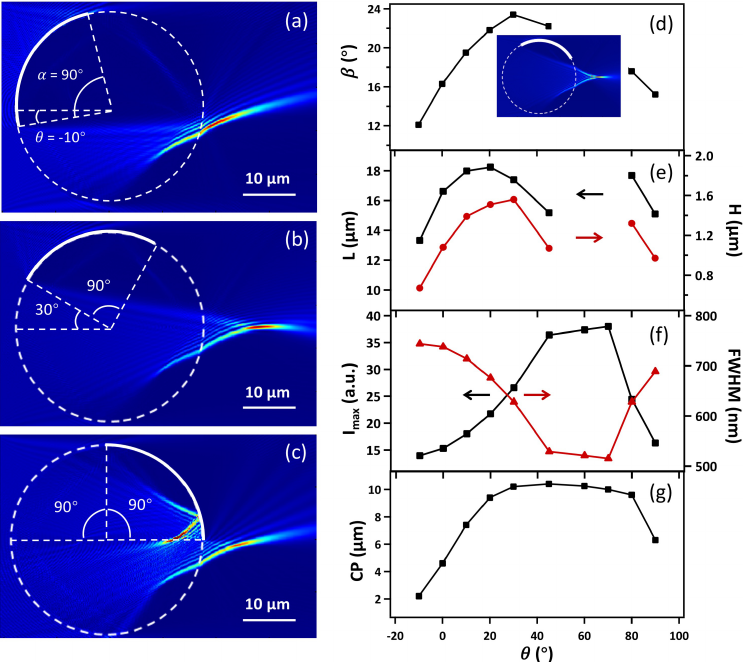
Figure 5. ( a – c ) PHs generated by the 35 µ m-diameter patchy cylinder at different rotation angles: ( a ) θ = − 10 ◦ , ( b ) θ = 30 ◦ , ( c ) θ = 90 ◦ . ( d – g ) Characteristics of the PHs as a function of rotation angle θ : ( d ) bending angle β and the focus of a patchy particle at θ = 60 ◦ (the inset), ( e ) subtense L (black line) and hook height increment H (red line), ( f ) maximum intensity enhancement factor I max (black line) and the corresponding FWHM (red line), ( g ) distance between the I max position and the right edge of the cylinder